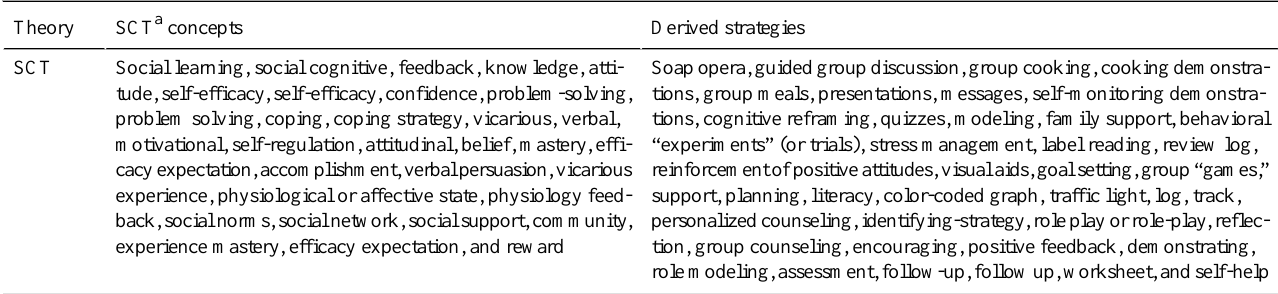
Table 1. Social cognitive theory concepts and derived strategies.